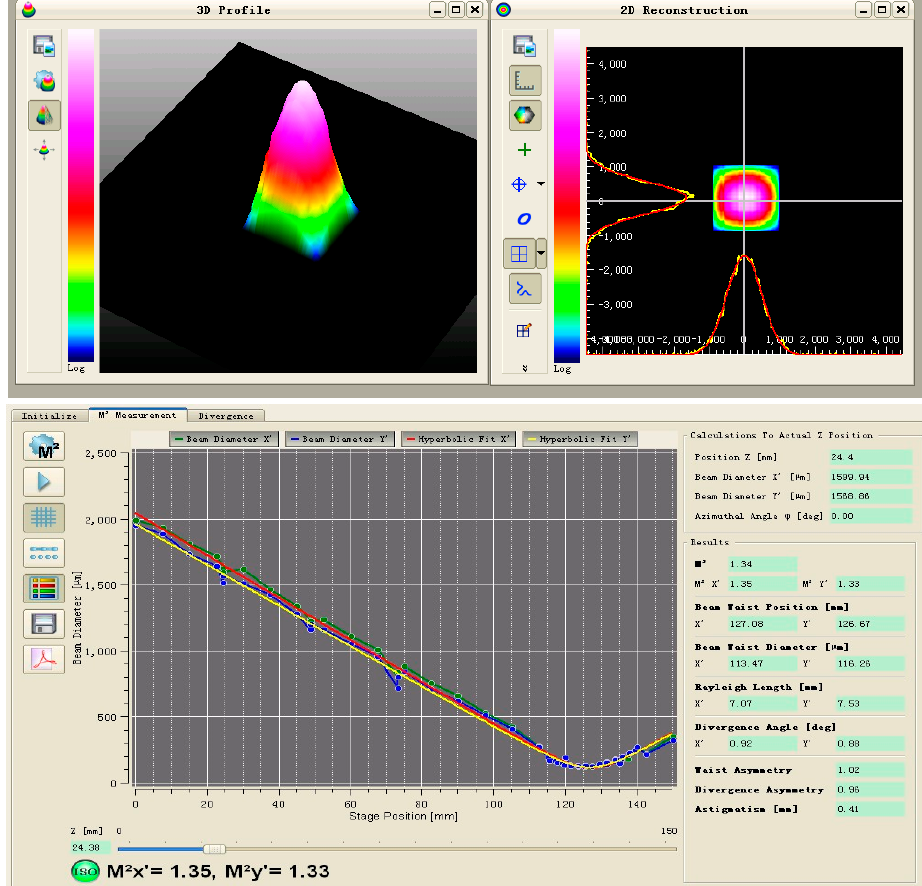
Figure 9. Beam quality M 2 measurement results.